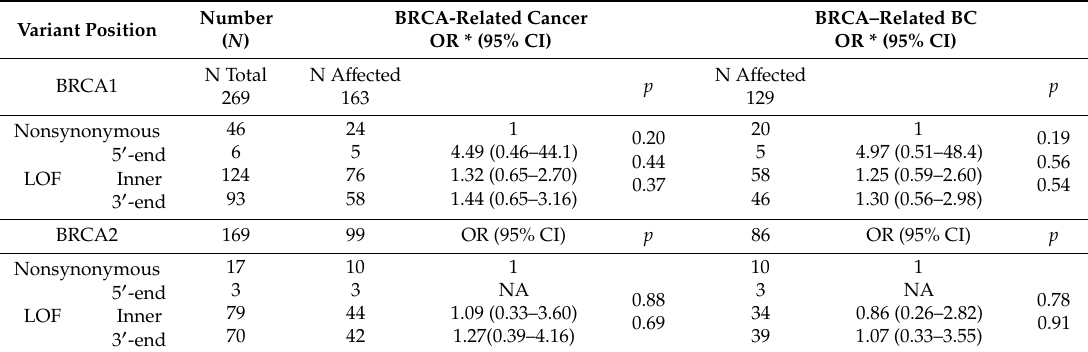
Table 5. Association between BRCA-related cancer risk and the variant type and